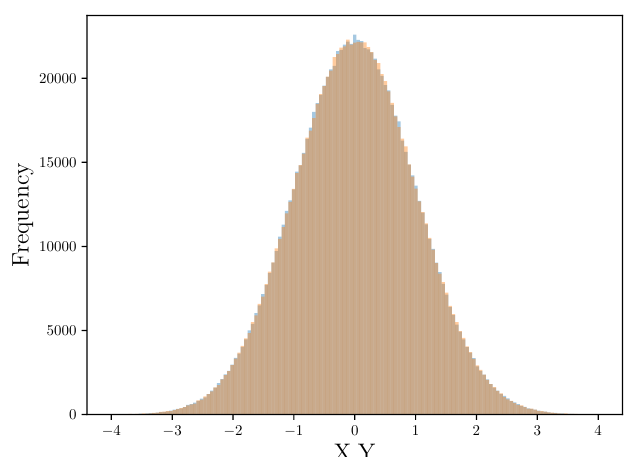
Figure 4: We show that in the limit of large sample size (here 10 6 ), the prescription we use for generating random numbers tends to the desired Gaussian distribution with mean zero and unit